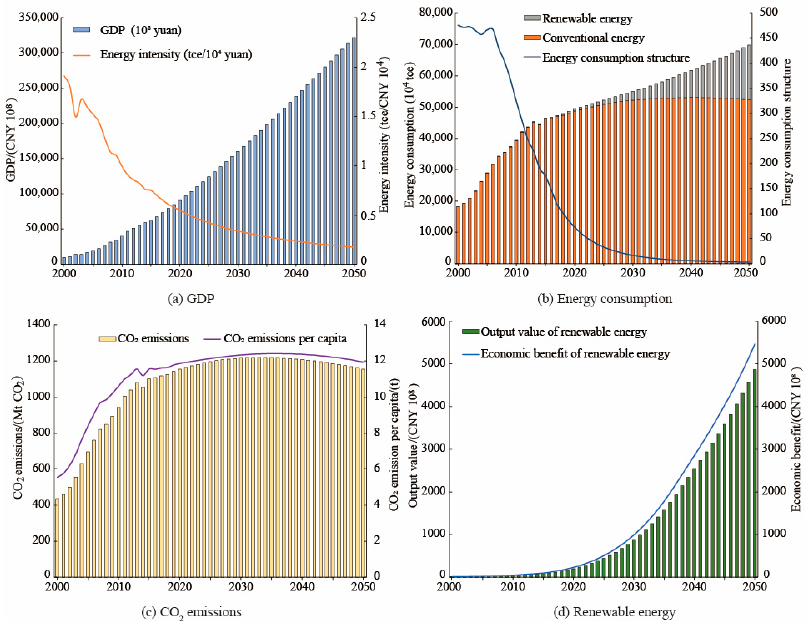
Figure 3. Simulation results of baseline scenario.